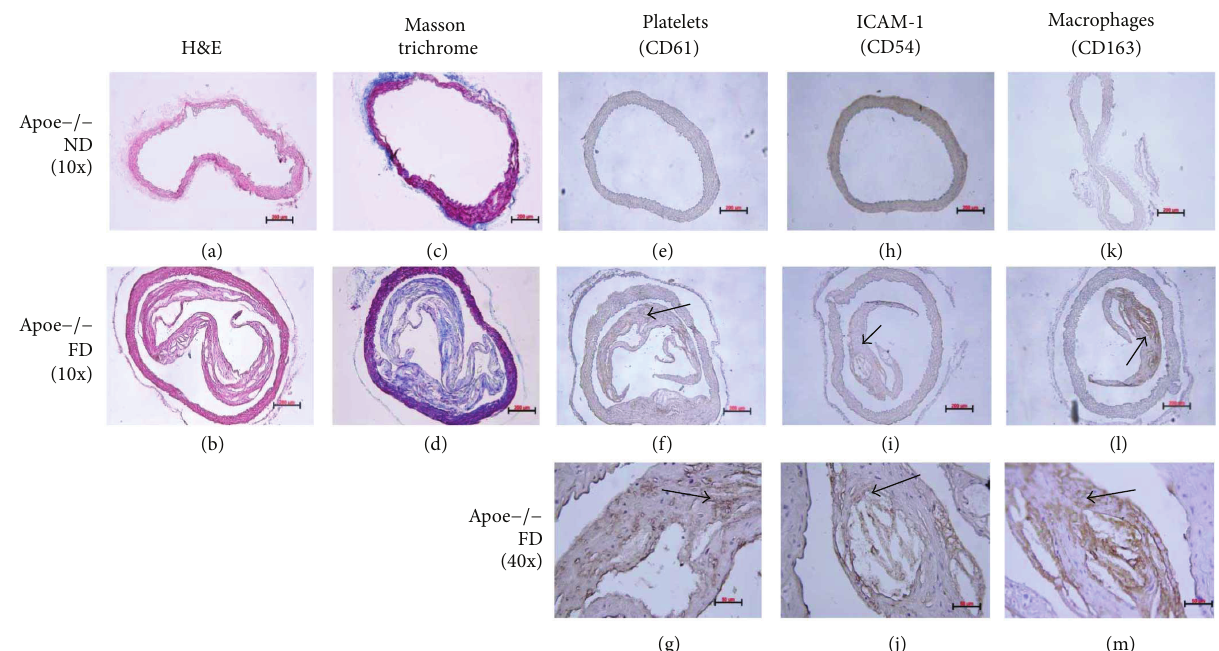
Figure 2: APOE −/− mice. Advanced atherosclerosis model. ((a), (c)) Histological section of APOE −/− mice fed with ND. ((b), (d)) Histological section of ApoE −/− mice fed with FD. H&E staining and Masson trichrome. (e) Histological section of ApoE −/− mice fed with ND. ((f), (g)) Histological sections of ApoE −/− mice fed with FD. Immunohistochemistry for platelets (CD61), 1/25. (h) Histological section of ApoE −/− mice fed with ND. ((i), (j)) Histological sections of ApoE −/− mice fed with FD. Immunohistochemistry for ICAM-1, 1/25. (k) Histological section of ApoE −/− mice fed with ND. ((l), (m)) Histological sections of ApoE −/− mice fed with FD. Immunohistochemistry for ICAM-1, 1/25. Scale bar: 50 and 200 𝜇